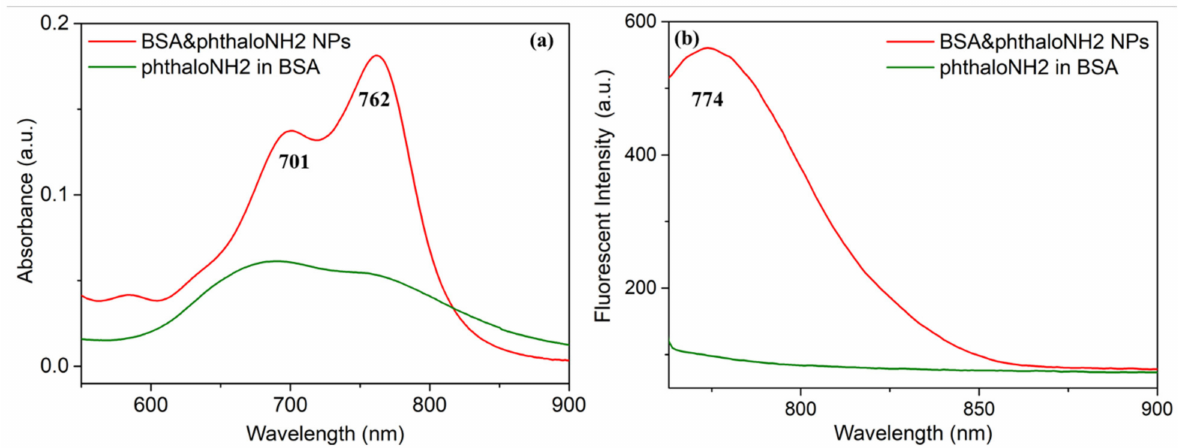
Figure 2. Absorbance ( a ) and fluorescence emission ( b ) spectra of the BSA&phthaloNH 2 NPs (red) and phthaloNH 2 in BSA solution (green). For both samples, the excitation wavelength was fixed at 745 nm. We used a concentration of 10 − 5 M phthaloNH 2